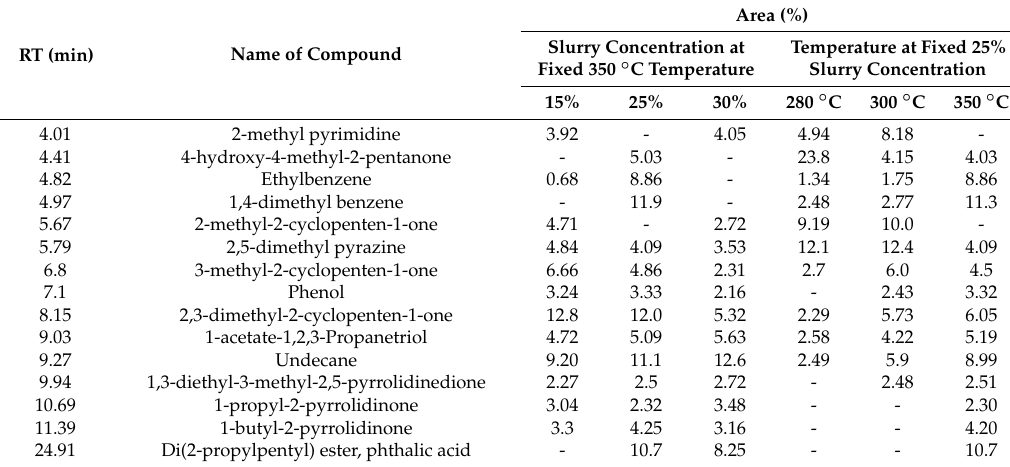
Table 3. Major compounds of recovered bio-oils obtained from HTL under various solid concentrations and temperature using